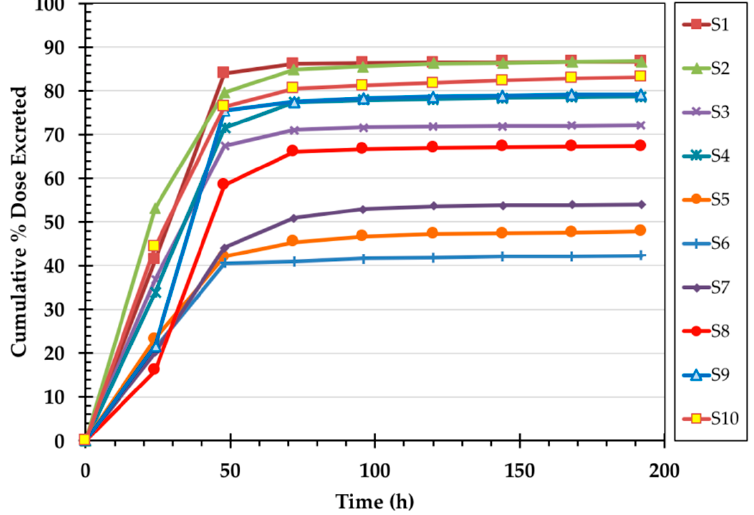
Figure 6. Time course of total % dose excreted after ingestion of in vivo labeled egg.